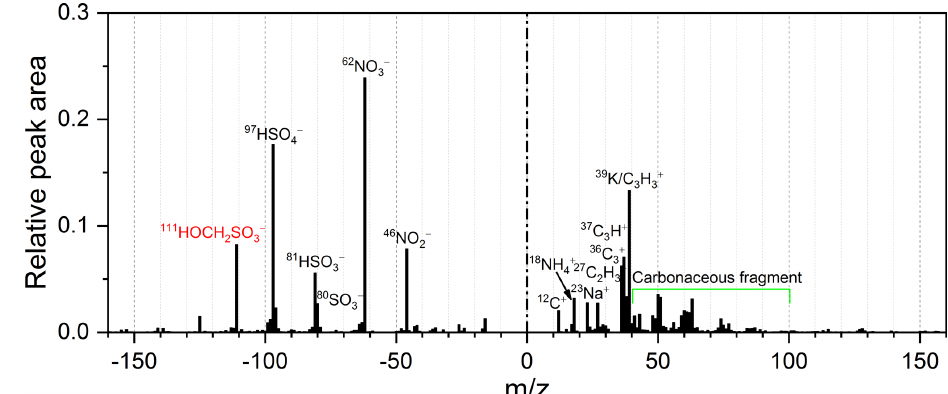
Figure 1. Presence of HMS in single-particle mass spectra during winter in Beijing. The peak at m/z 111 in the negative ion mode is attributed to HMS (HOCH 2 SO − negative ion spectrum, indicating the presence of sulfur species and nitrate. In the positive mass spectra, inorganic ions ( m/z 18 NH + Na + , and 39 K + ), elemental carbon ( m/z 12 C + , 36 C + C 2 H 3 O + ) are present.